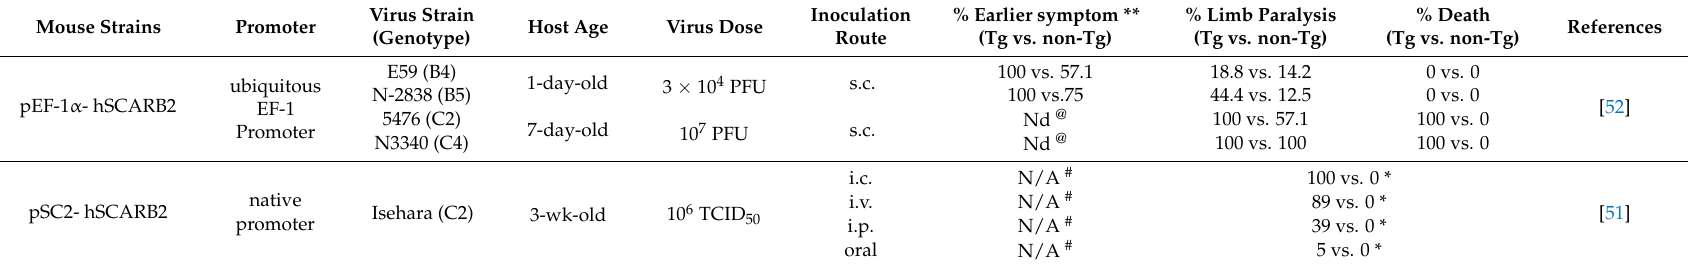
Table 3. Comparisons between human SCARB2-transgenic and wild type non-transgenic mice in EV71 infection and